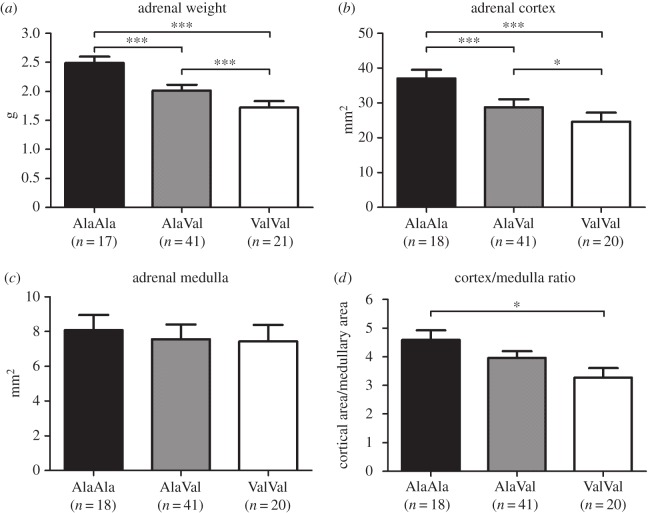
Effect of the GRAla610Val substitution on weight and structure of the adrenal gland (left). (a) Adrenal weight; (b) cross-sectional area of the adrenal cortex; (c) cross-sectional area of the adrenal medulla; (d) cortex/medulla ratio calculated using their cross-sectional areas. Data are presented as least-squares means ± s.e. *p < 0.05, **p < 0.01, ***p < 0.001.